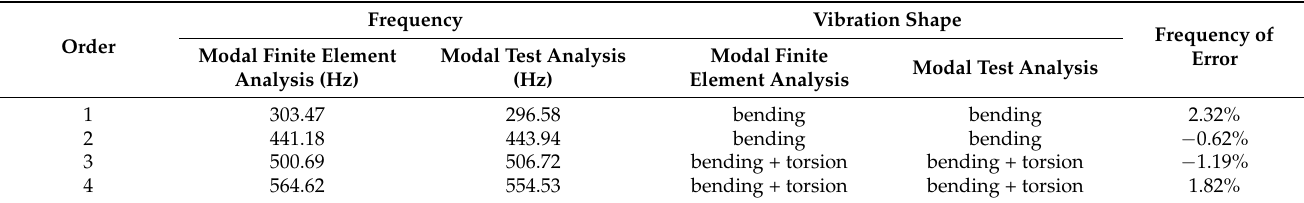
Table 2. Comparison of modal results between the finite element analysis and the